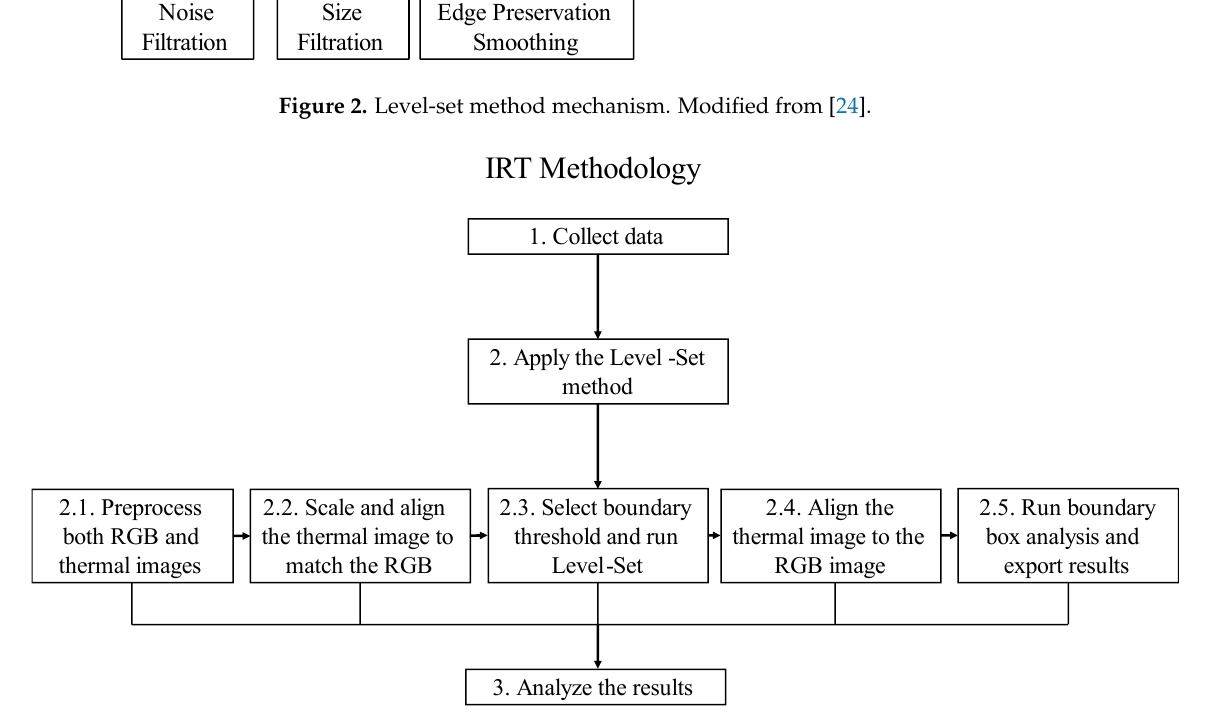
Figure 4. Slab dimensions.